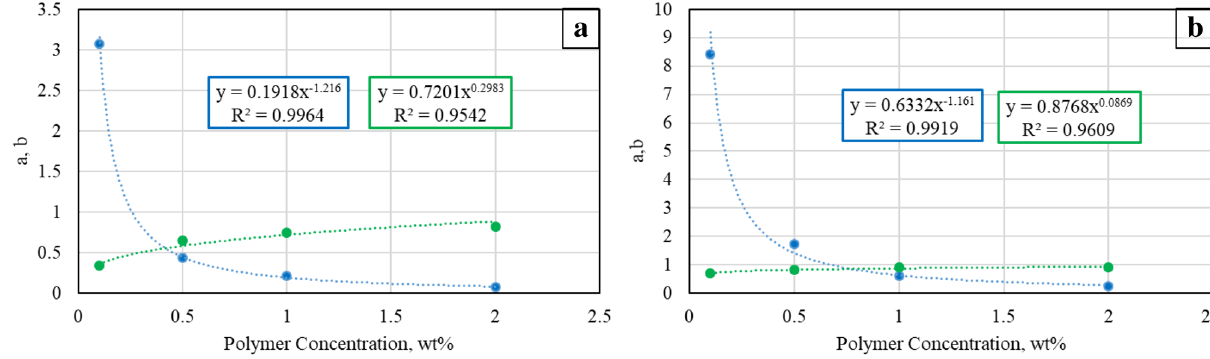
Fig. 3 a and b coefficients for a 1/16 inch b 1/8 inch